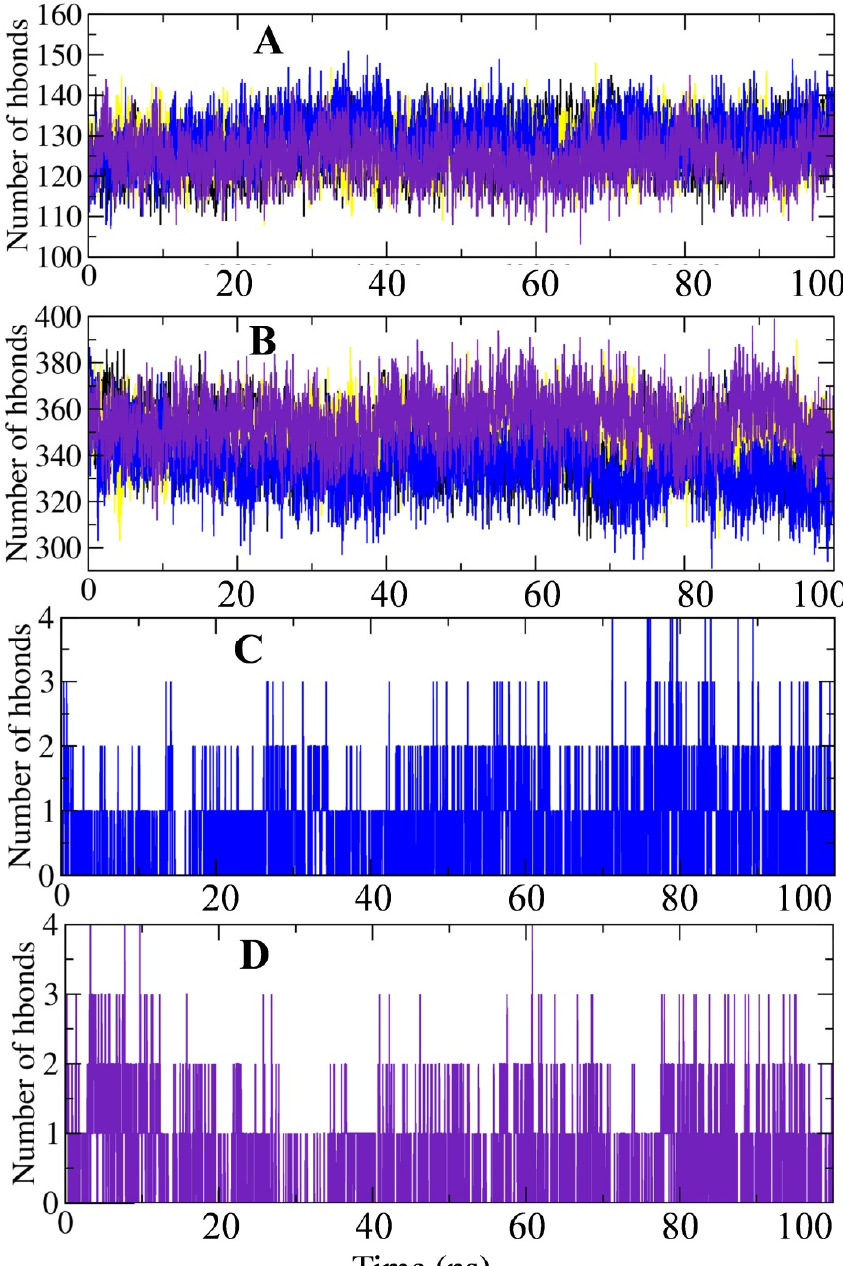
Figure 3. Effect of the M46I mutation on the hydrogen bond formation pattern of saquinavir-bound HIV-1 protease. ( A ) Hydrogen bond formation pattern within the protein, ( B ) hydrogen bond formation pattern between the protein and the surrounding water molecules, ( C ) hydrogen bond formation pattern between the wild-type protease and saquinavir, and ( D ) hydrogen bond formation pattern between the M46I-mutation-carrying protease and saquinavir during the 100 ns simulation. The black, blue, yellow, and purple colors represent the wild-type, saquinavir-bound wild-type, M46I-mutation-carrying protease, and saquinavir-bound mutation-carrying protease systems, respectively.